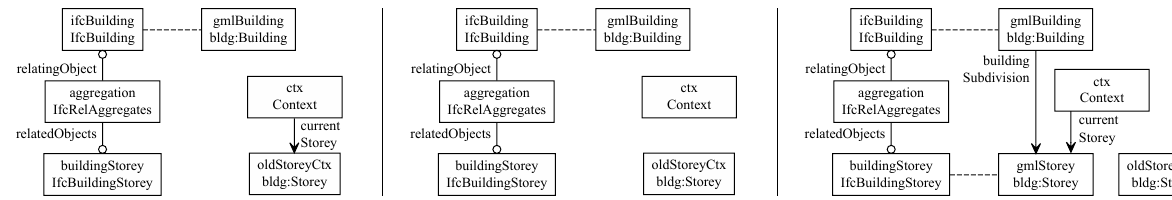
Figure 3. Forward transformation rule, explicit representation with left hand side (left), glue graphs (centre) and right hand side (right) of a triple graph transformation rule